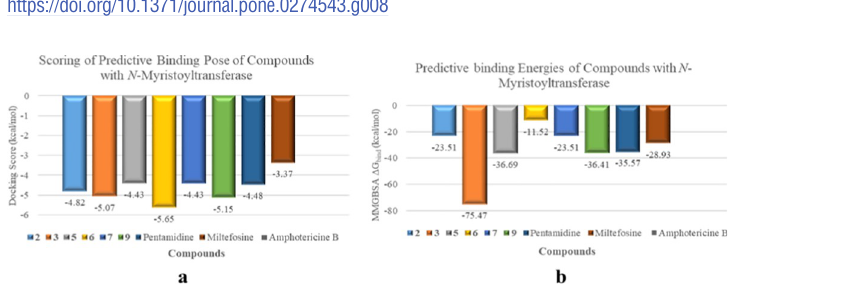
Fig 9. Docking scores of selected compounds 2, 3, 5, 6, 7, and 9 against leishmanial N -myristoyltransferase (lipid metabolism).